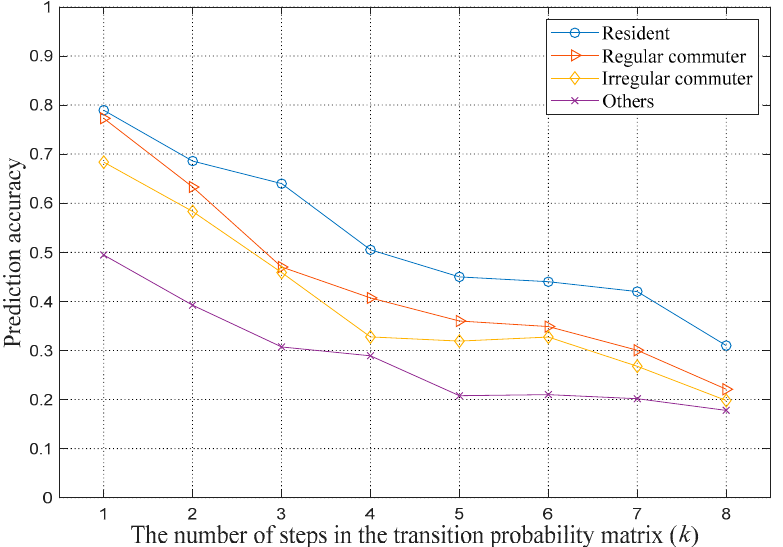
Figure 3. Prediction accuracy of Markov models based on different steps k